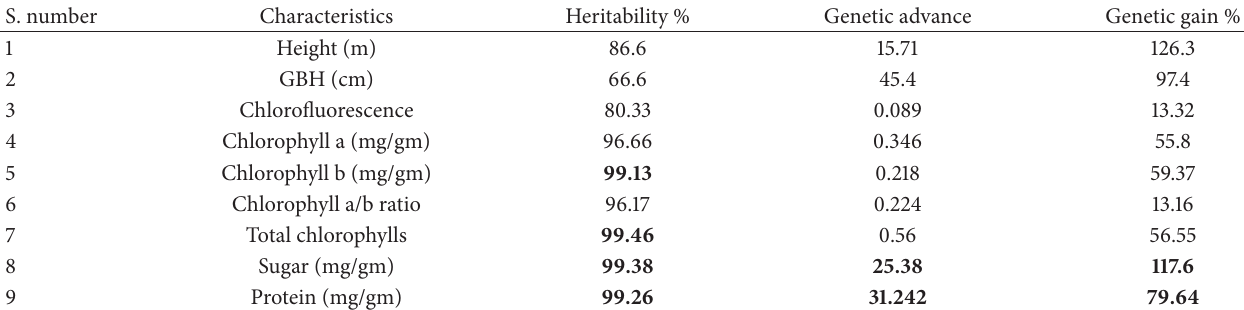
Table 3: Estimation of heritability, genetic advance, and genetic gain in various traits. S.